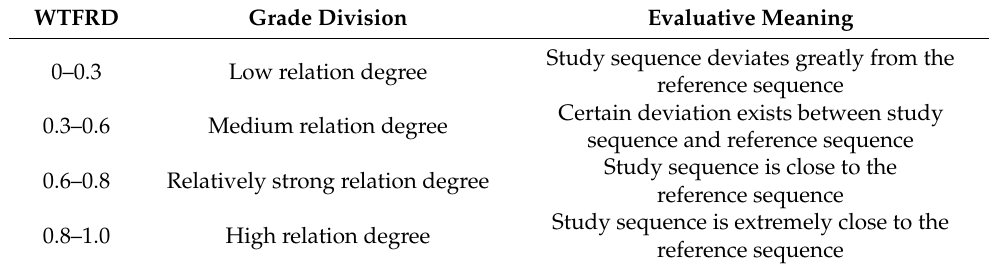
Table 3. Grading of water table fluctuation relation degree (WTFRD) [59,60].